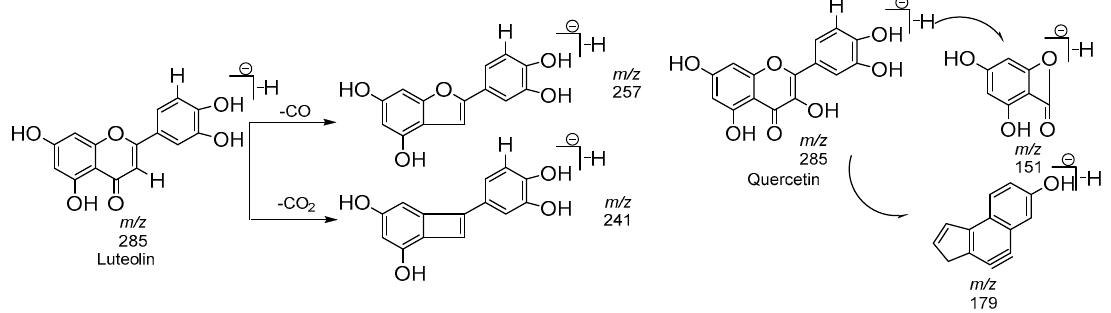
Figure 5. Fragmentation pathway of flavonoids.